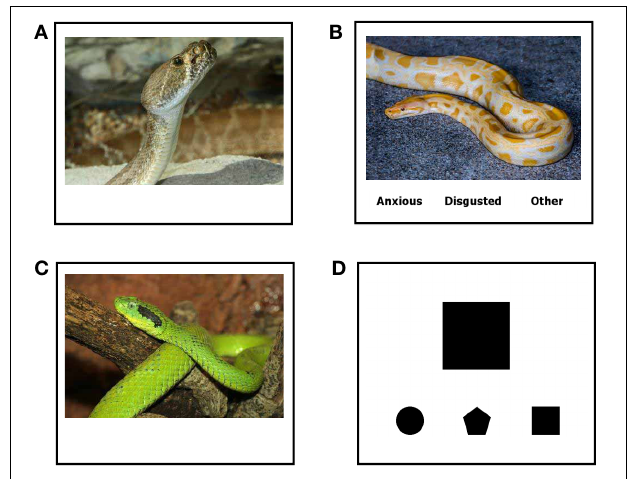
FIGURE 1 | Stimuli. Sample screens from the (A) Reappraisal, (B) Label, (C) Observe, and (D) Shape Match conditions. Although specific images for Reappraisal, Label, and Observe were distinct, they were matched on content, valence, and arousal. (Note: The pictures shown in Figure 1 are similar to the stimuli used in this study, but are not actual IAPS